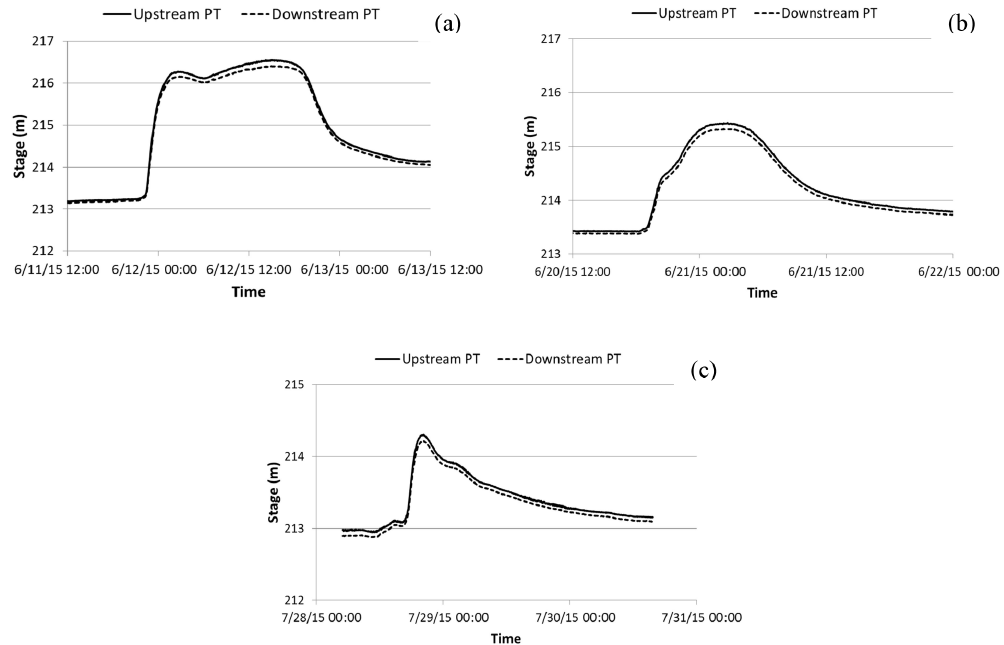
Figure 4. Event stage hydrographs for the selected three events: (a) Event 1, (b) Event 2, and (c) Event 3. The horizontal axis represents time and the vertical axis represents stages in the NAVD